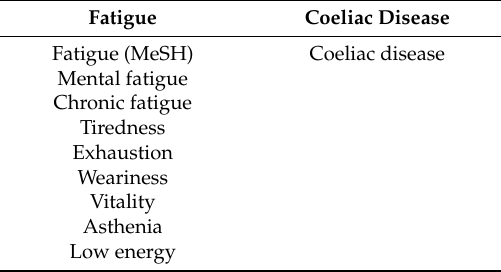
Table 1. Search terms used for literature